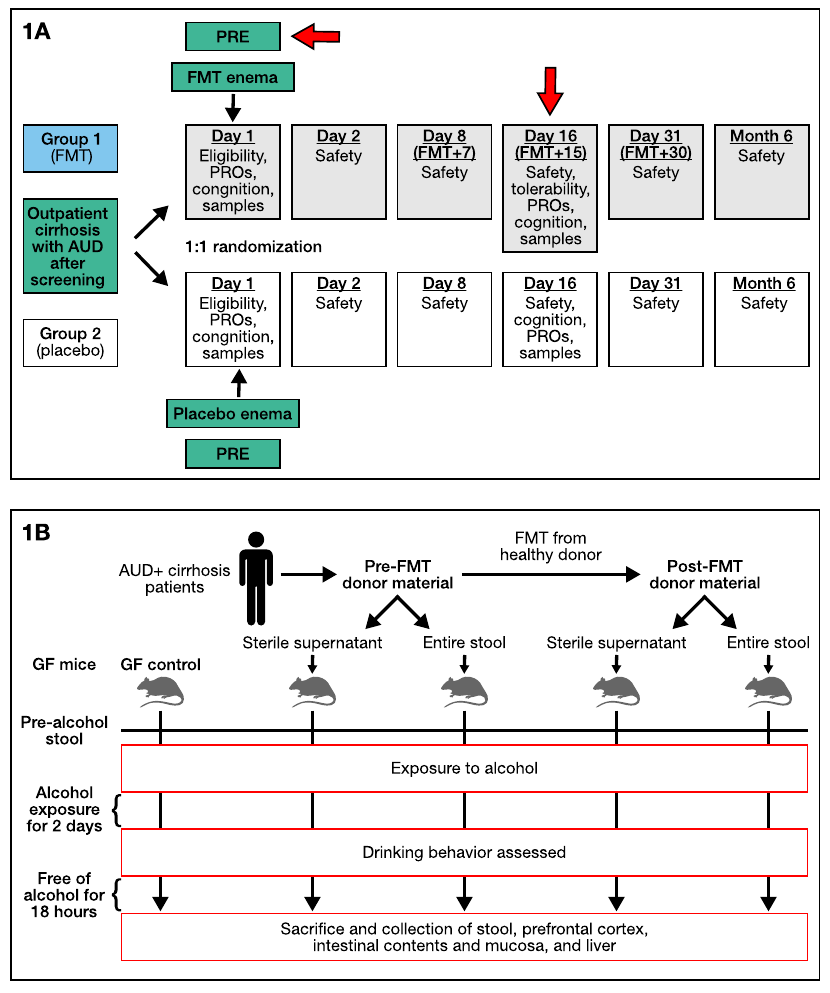
Fig.1|Studydesign.A HumanRCTdesignwithredarrowsatthetimepointsstools from humans were collected for colonization into germ-free mice. B Animal experiment design from human to male germ-free C57BL/6J mouse stool transfer